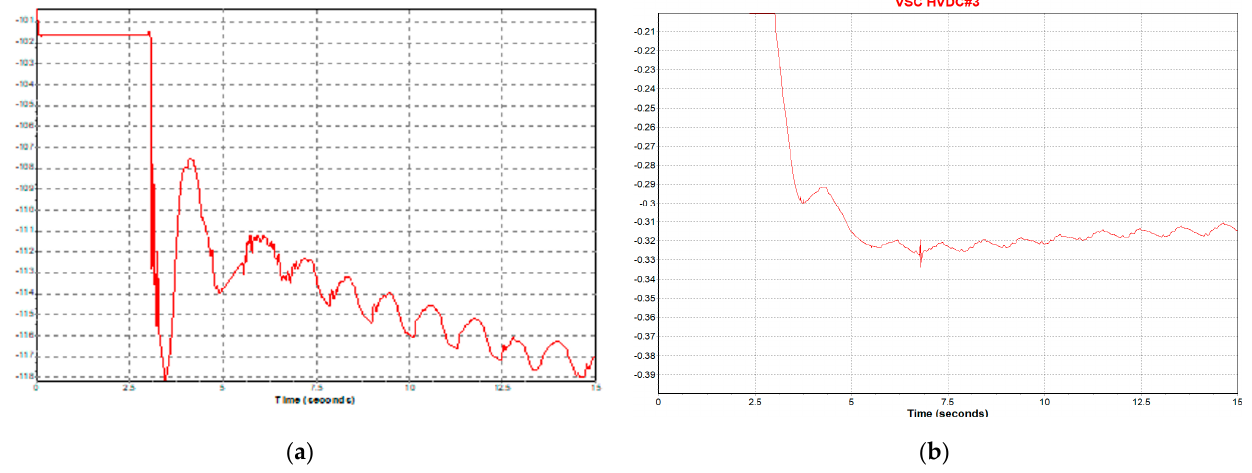
Figure 8. Output characteristics by the HVDC model: ( a ) UDM HVDC Output characteristics and ( b ) VSC HVDC Output characteristics.